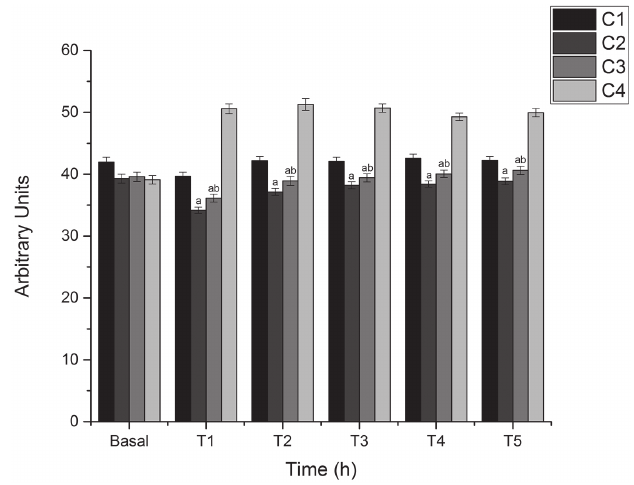
FIGURE 1 ‑ Stratum corneum hydration values measured before and at 1, 2, 3, 4 and 5 hours after single application of formulations (Mean ± SE). Notes: a = p-value < 0.05 for Anova + Tukey post-test vs. negative control. b = p-value < 0.05 for Anova + Tukey post-test vs. C2. C1 – Negative control; C2 – vehicle; C3 – Vehicle + 0.5% Kalanchoe brasiliensis extract; C4 – Positive control. T1 – After one hour; T2 – After two hours;